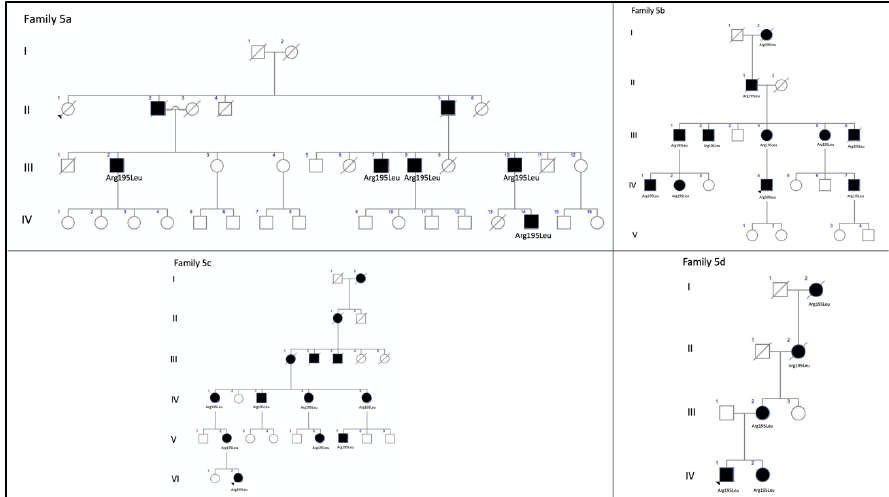
Figure 11. The pedigrees from the four branches of family 5 exhibit a dominant inheritance pattern. The family tree is based on clinical data shown here. The known affected individuals in each family are indicated by a black symbol.